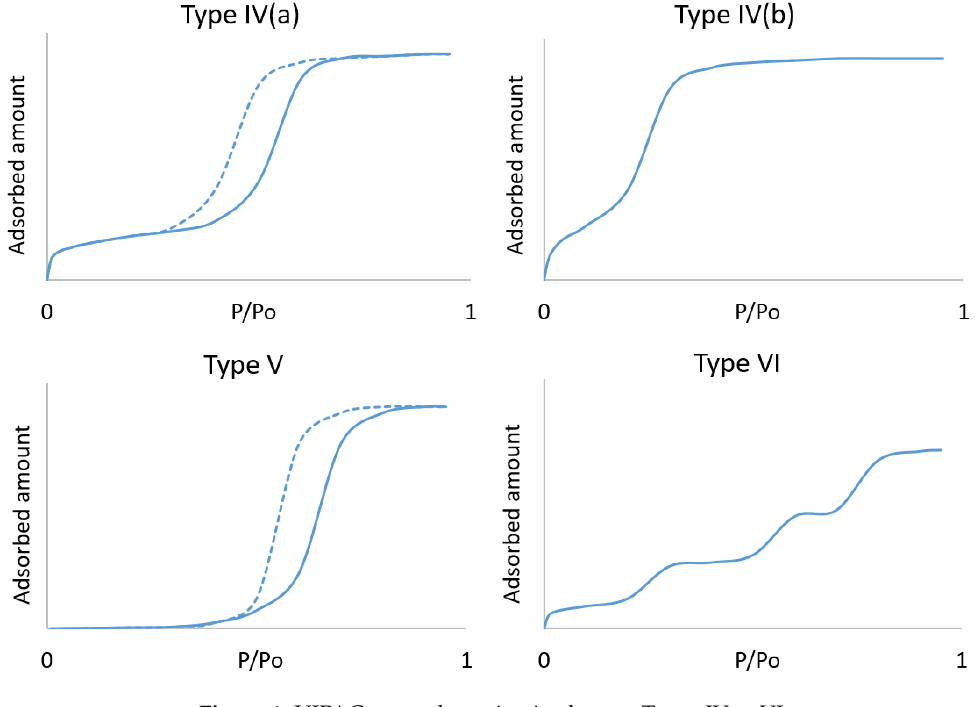
Figure 1. UIPAC type adsorption isotherms, Types IV to